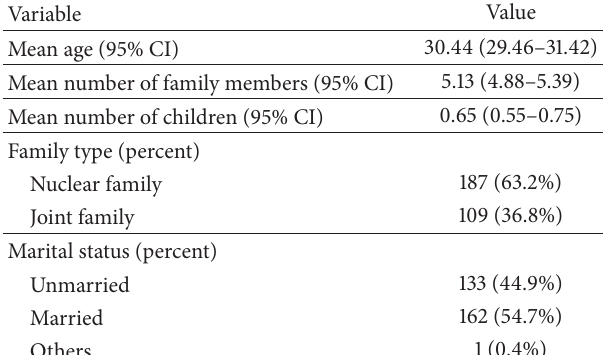
Table 1: Descriptive analysis: sociodemographic and work related